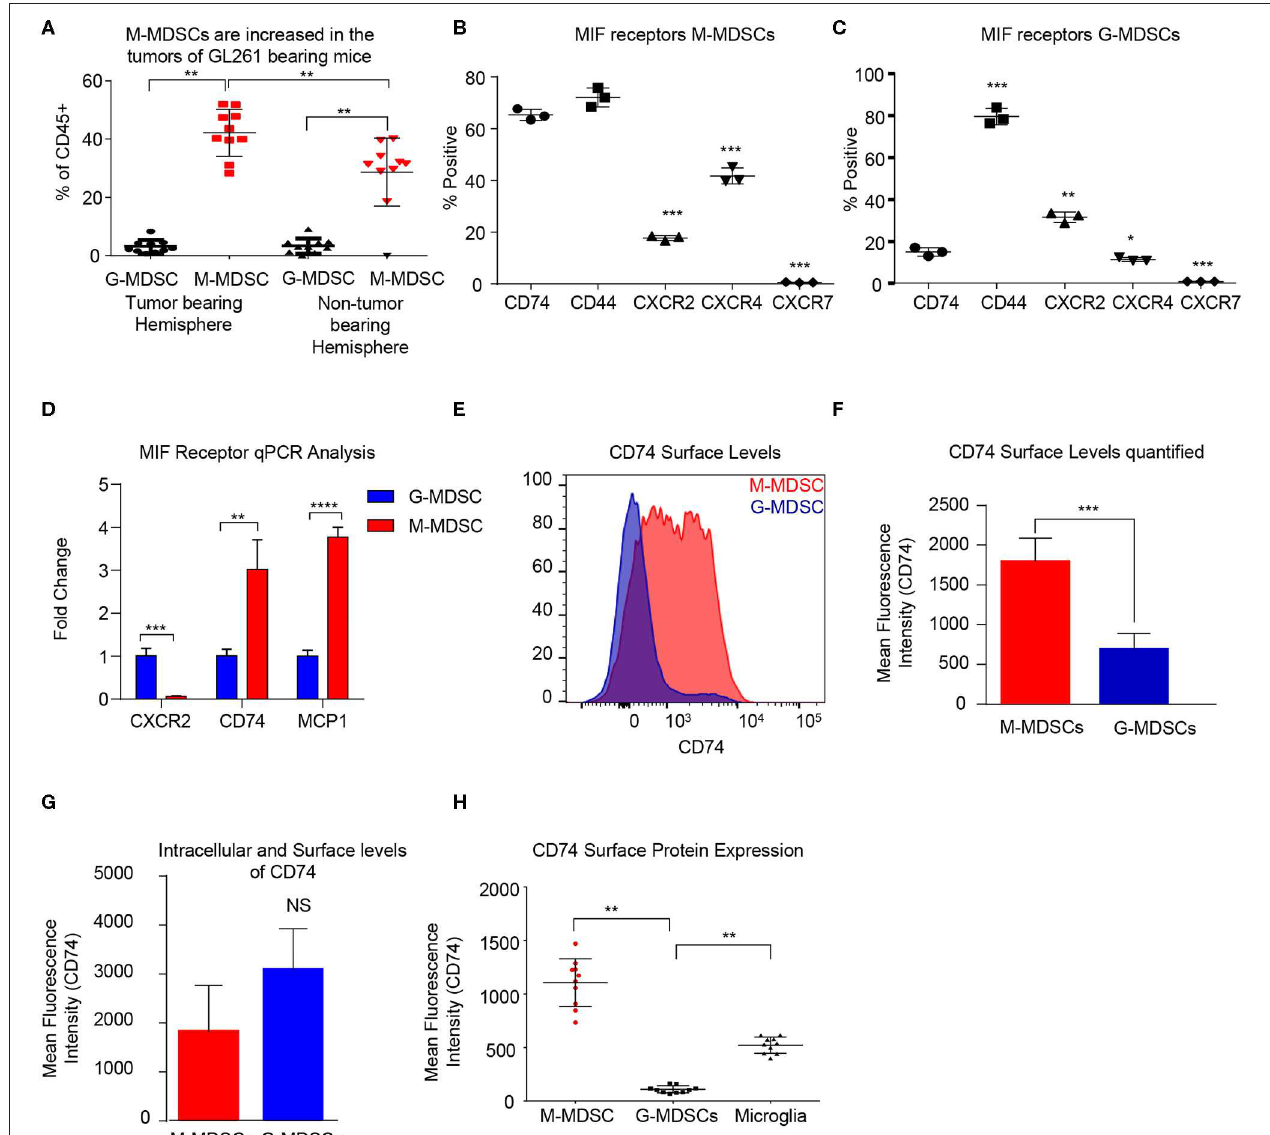
FIGURE 2 | Murine M-MDSCs express the MIF receptor CD74 . n = 10 mice were intracranially injected with the syngeneic mouse glioma cell line GL261 at day 0 and then at Day 18 post injection the tumor bearing and non-tumor bearing hemispheres were resected, dissociated, and analyzed by flow cytometry (A) . M-MDSCs Live/CD45 + / CD 11 b + / CD 68 − / P 2 Ry 12 − / MHC − / Ly 6 C + / Ly 6 G − , and G-MDSCs Live/CD45 + / CD 11 b + / CD 68 − / P 2 Ry 12 − / MHC − / Ly 6 C + / Ly 6 G + . n = 3 mice were used for co-culture induction of MDSCs and at day 3 M-MDSCs and G-MDSCs were analyzed for the MIF receptors CD74, CD44, CXCR2 CXCR4, and CXCR7 by flow cytometry and gated for the % positive in each group (B, C) . FACs sorting of G-MDSCs and M-MDSCs from co-cultures of n = 3 mice were performed and then RNA isolated for qPCR analysis of the expression of MIF receptors (CXCR2, and CD74) as well as MCP-1, the CD74 downstream activation product (D) . CD74 expression was assessed by flow cytometry using flow cytometry staining of co-cultures where the histogram demonstrates the expression level of CD74 on M-MDSCs compared to G-MDSCs (E) . Quantification of n = 3 co-culture derived M-MDSCs and G-MDSCs CD74 Mean Fluorescence intensity shows higher levels of CD74 on M-MDSCs (F) . Intracellular staining post permiablization of the same cohort of M-MDSCs and G-MDSs from (F) shows that CD74 levels were not significantly different when staining internally (G) . In vivo , the tumor bearing mice that were evaluated for MDSC levels in (A) were also evaluated for CD74 expression on the surface of M-MDSCS, G-MDSCS and Microglia (H) . Two-Tailed T -Test was performed for comparisons in (A, D, F, G, H) . *<0.05, **<0.01, ***<0.001.